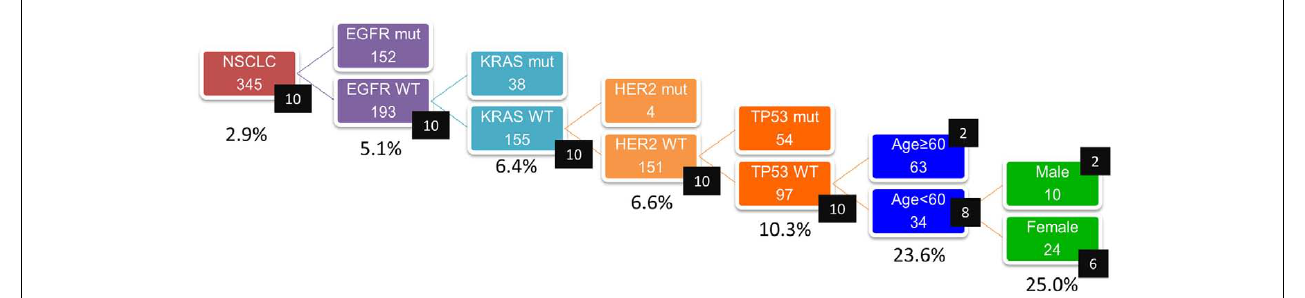
became 25% when patients were confined to those without EGFR, KRAS, HER2, p53 mutations and to female patients younger than 63. However, four patients were not included in this subset (Mitsudomi et al., 2010).